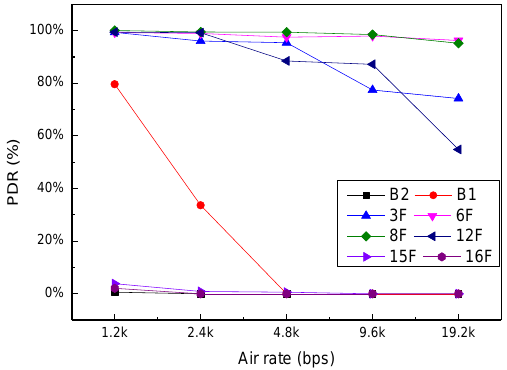
Figure 17. Relationship between PDR and air rate in the different floors.